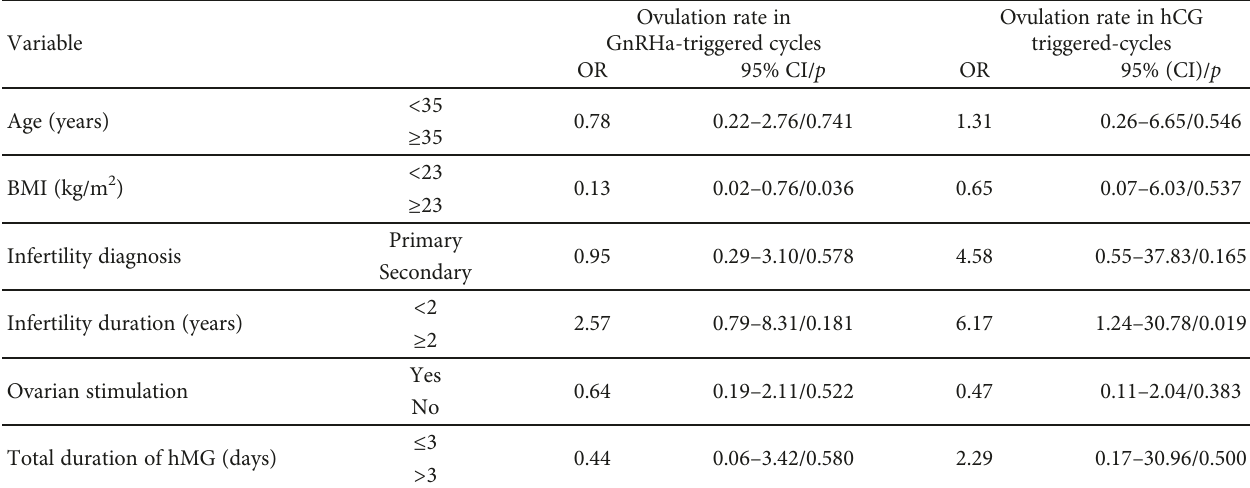
Table 2: Characteristics and outcome of the ovulation rate in GnRHa- and hCG- triggered